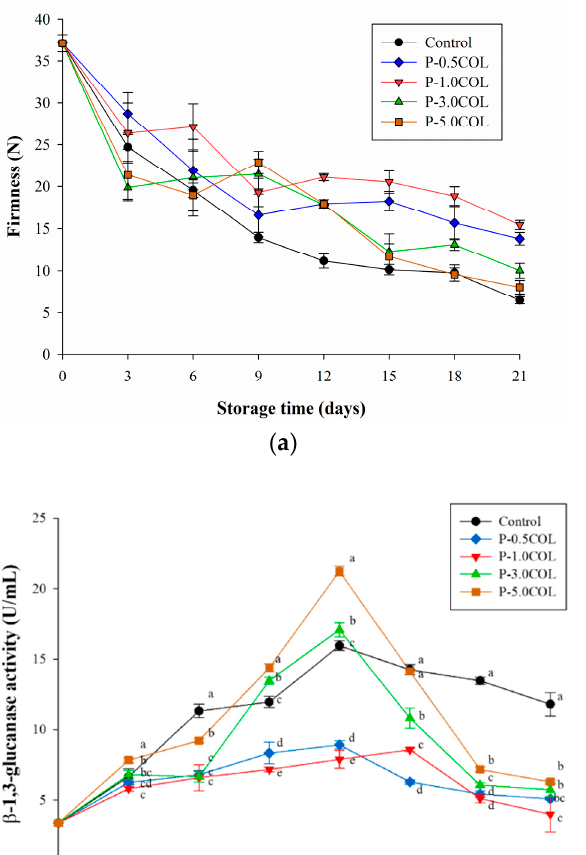
decline in different COL packaging films. ( b ) Firmness decline in different CMC packaging films. ( c ) β -1,3-Glucanase